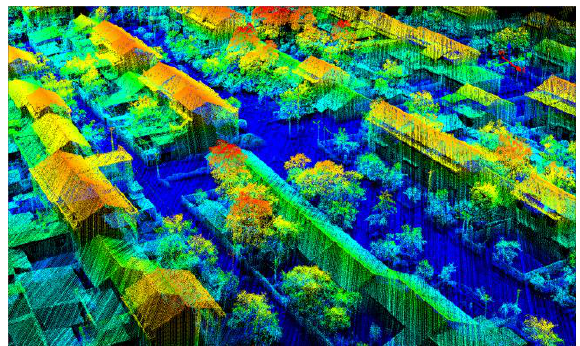
Figure 6 Point cloud data displayed with elevation.